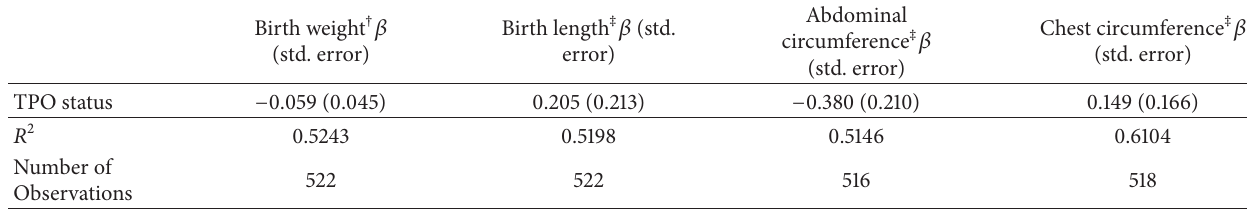
Table 4: Regression results for fetal/infant body growth variables at